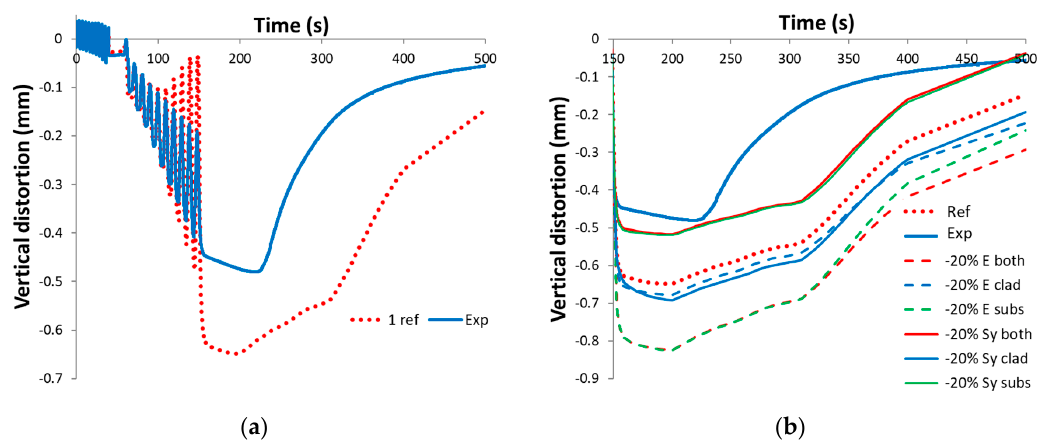
Figure 18. ( a ) Correlation between measured and predicted vertical displacements (– down, + up) during the cladding process, including the preheating and cooling stages. ( b ) Sensitivity analysis in the cooling stage to negative variations of Young’s modulus ( E ) and the elastic limit (Sy) of the clad and the substrate.